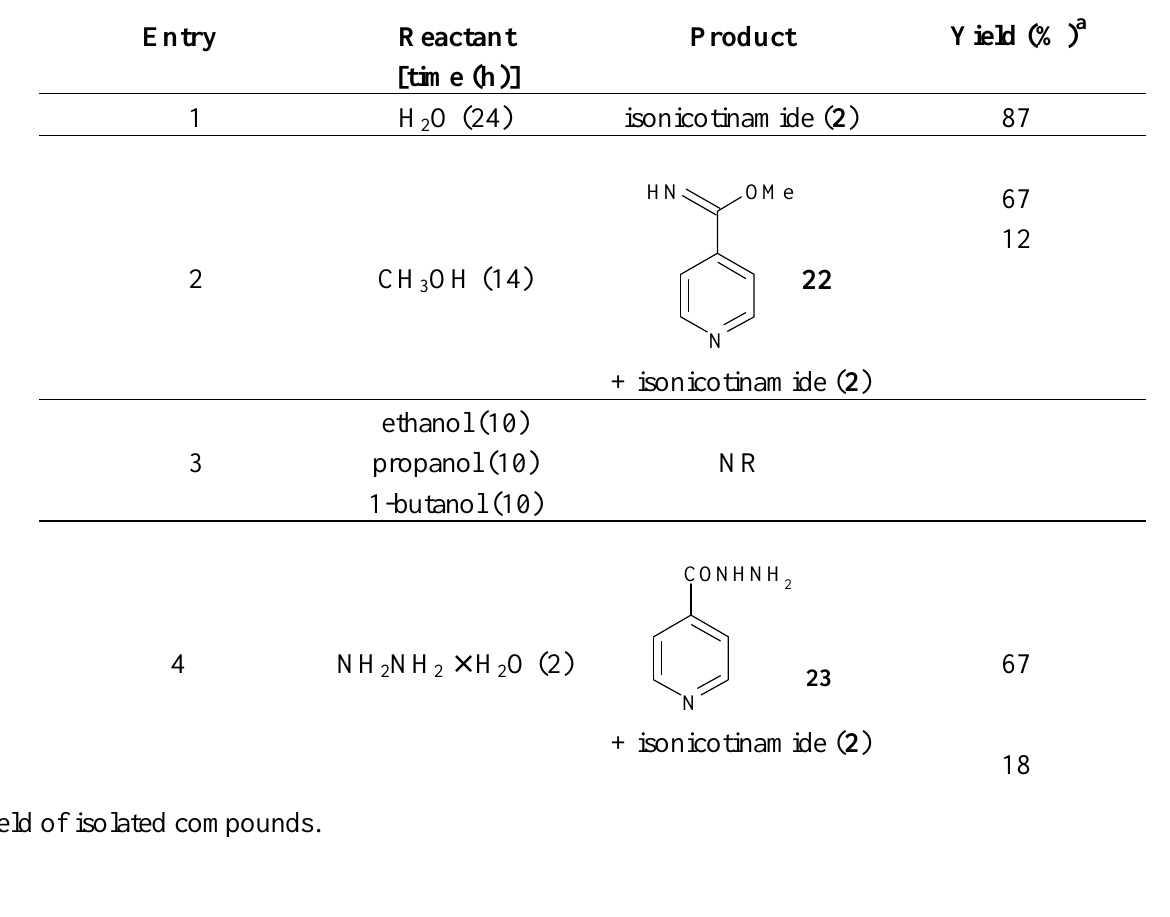
Table 2. Solvolysis of 4-cyanopyridine ( 1